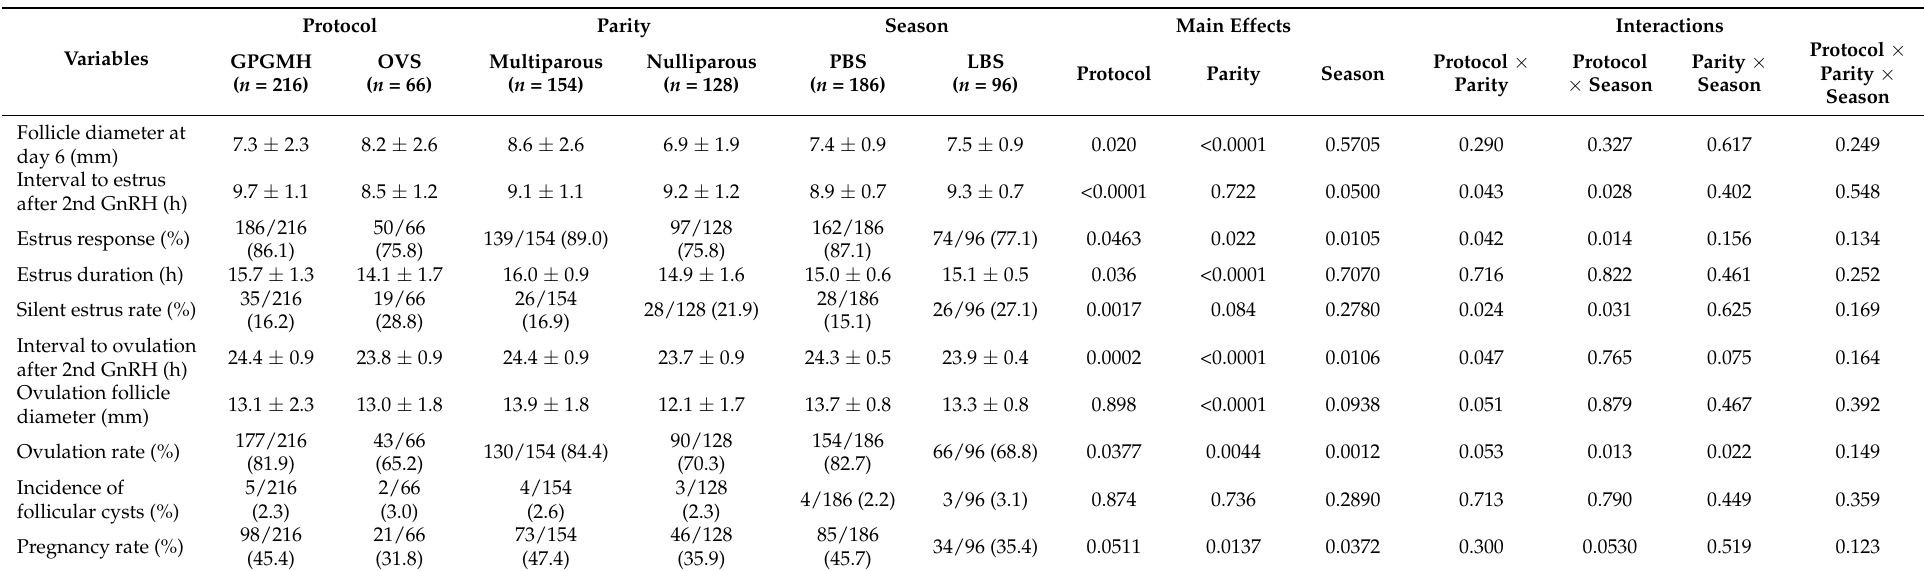
Table 1. Effect of protocol (GPGMH vs. OVS), parity (nulliparous vs. multiparous), season (peak breeding season (PBS) vs. low breeding season (LBS)), and their interactions for different reproductive parameters of crossbred